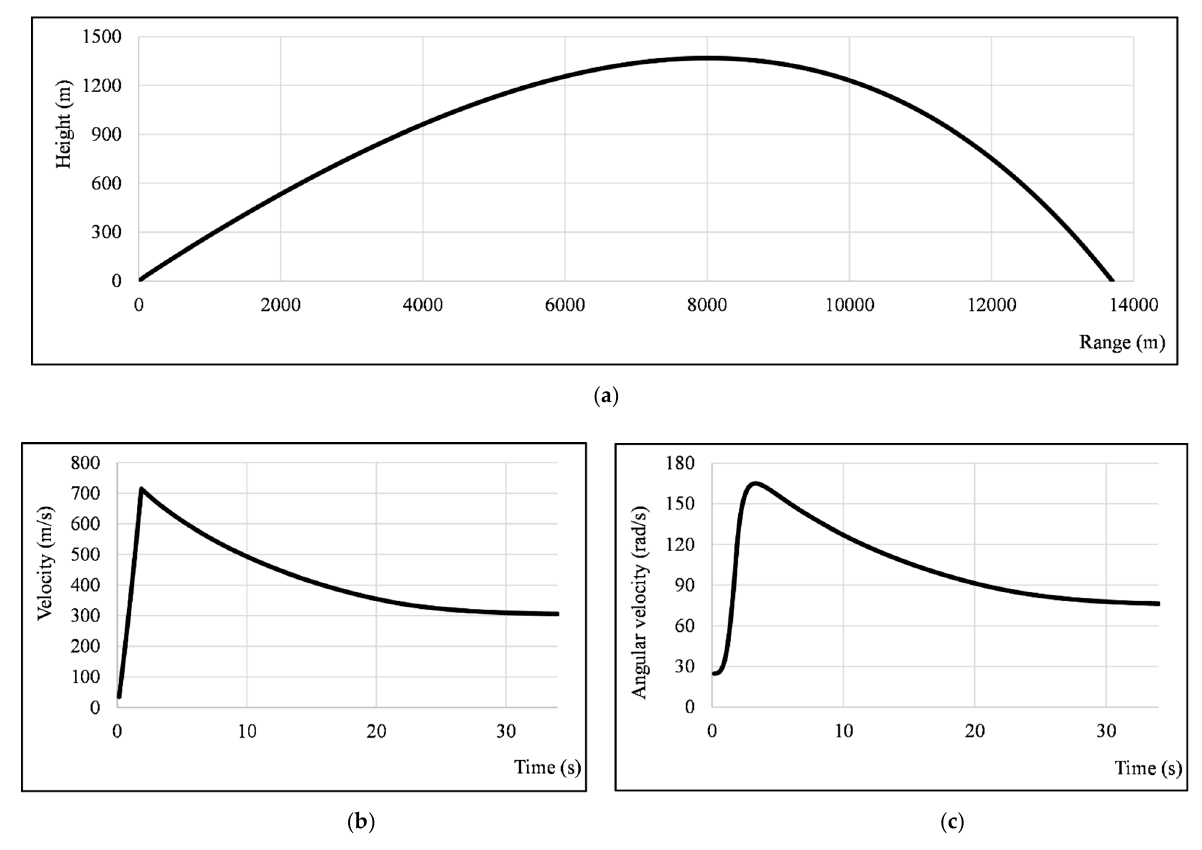
Figure 9. For an ideal projectile: trajectory ( a ), flight velocity ( b ), and angular velocity ( c ). The flight time is 34 s, and the trajectory apex is at 1367 m. The maximum velocity is 702 m/s, and the final velocity is 307 m/s. These data comply well with data gathered from the Firing Tables and the available technical documentation.